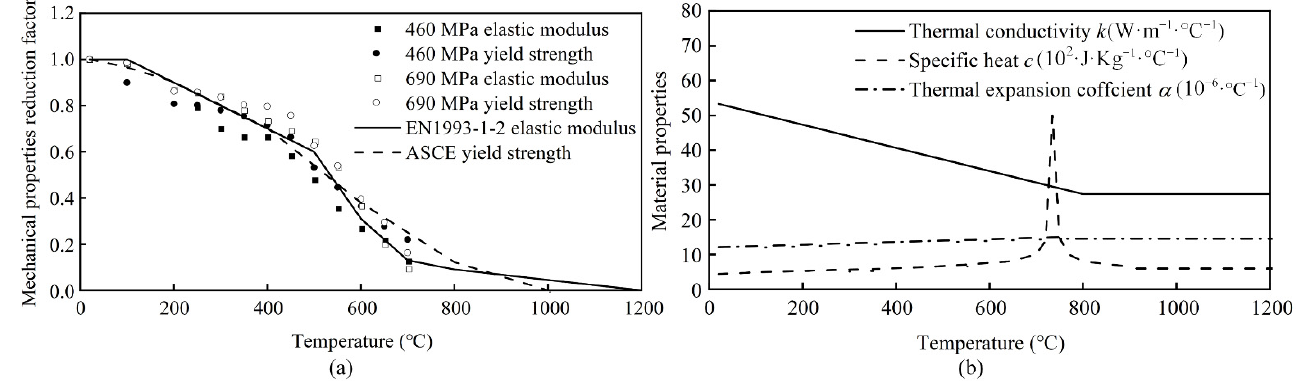
Figure 10. Mechanical and thermal properties of steel at elevated temperatures: ( a ) mechanical properties reduction factors, ( b ) thermal properties.